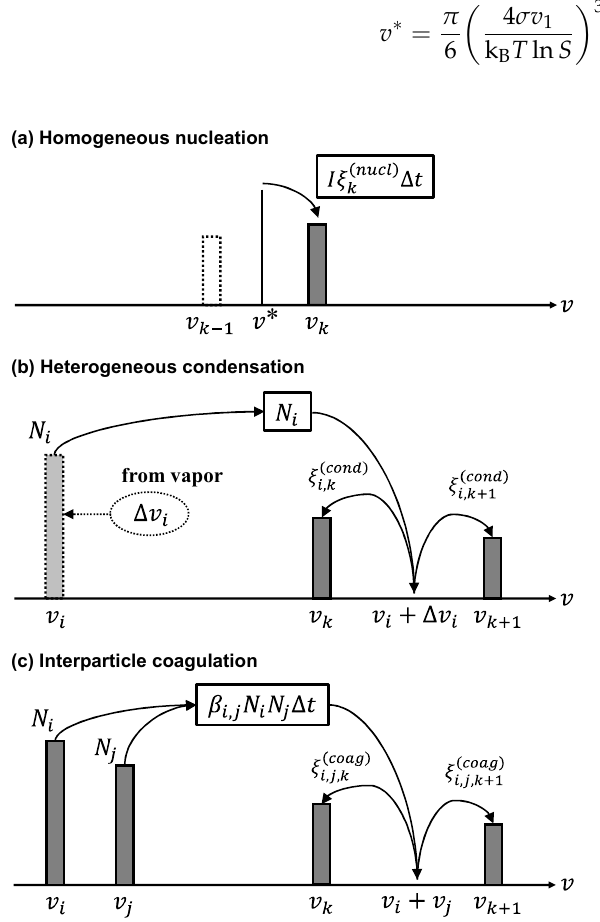
Figure 2. Illustrations depicting computations of ( a ) homogeneous nucleation, ( b ) heterogeneous condensation, and ( c ) interparticle coagulation.